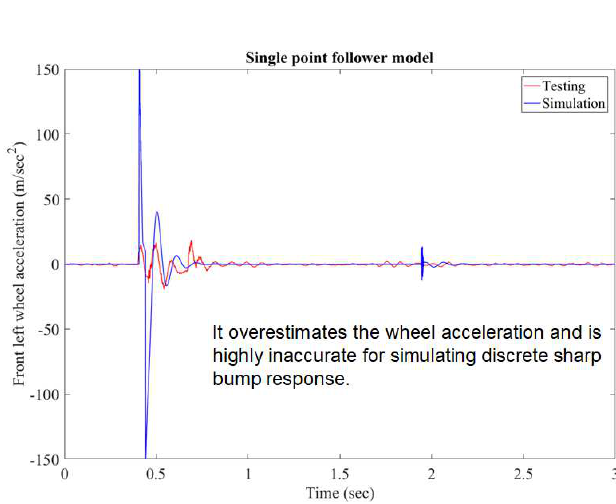
Fig. 5. Different tire terrain filtering models.